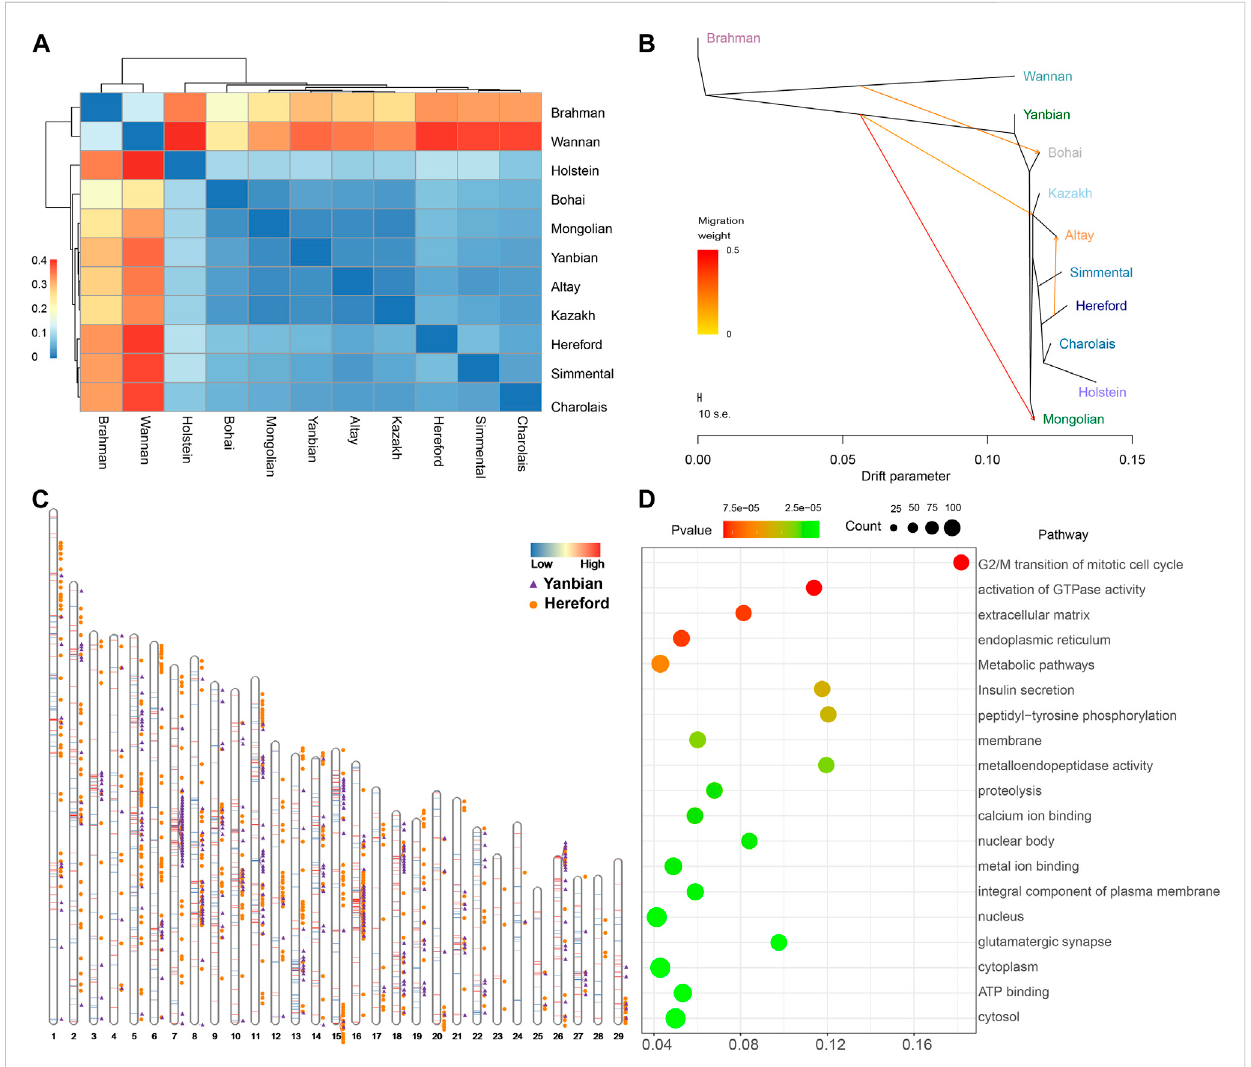
FIGURE 4 Relationship of Altay white-headed cattle and other cattle breeds. (A) Index of population divergence among 11 cattle breeds. (B) A maximum- likelihood tree is produced using TreeMix (up to migration 4). (C) Identi fi cation of segments in which ancestry proportions were considerably more remarkable than the percentage in the entire genome in Altay white-headed cattle. (D) KEGG and GO pathways derived from enrichment analysis of genes with high Hereford